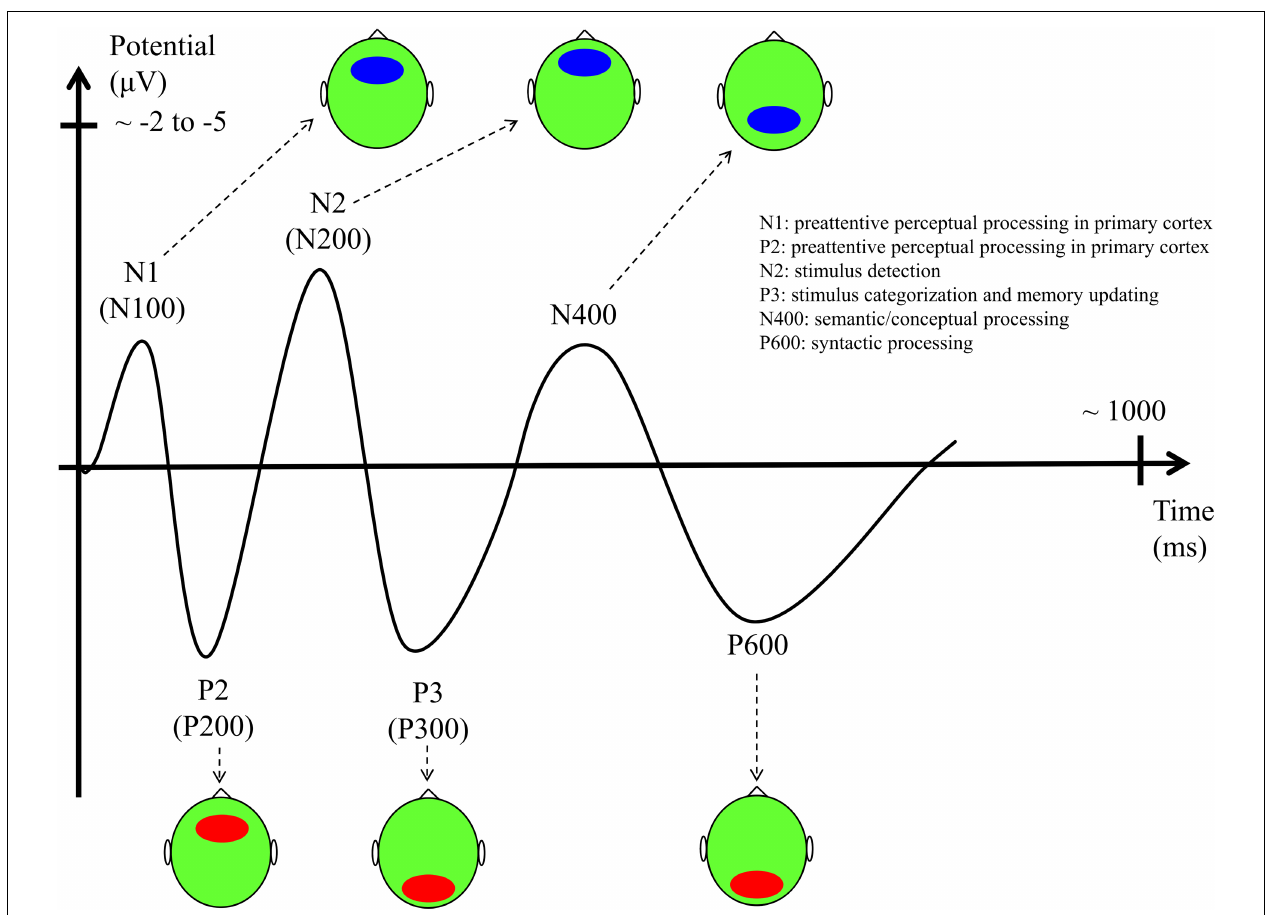
FIGURE 3 | Main ERP components with their functional interpretation, latencies, and scalp topography (ellipses indicate the scalp location where the component has the largest amplitude – red: positive